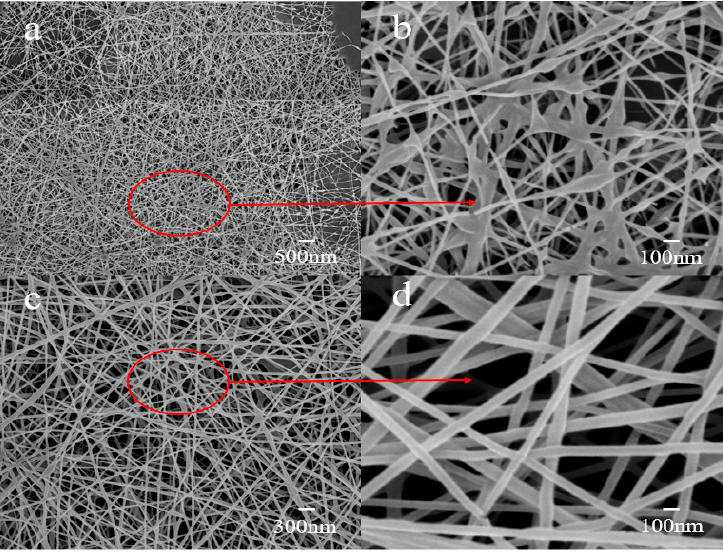
Figure 1. The morphology image of the electrospun KGM nanofibers ( a , b ) and KGM/PLA nanofibers ( c , d